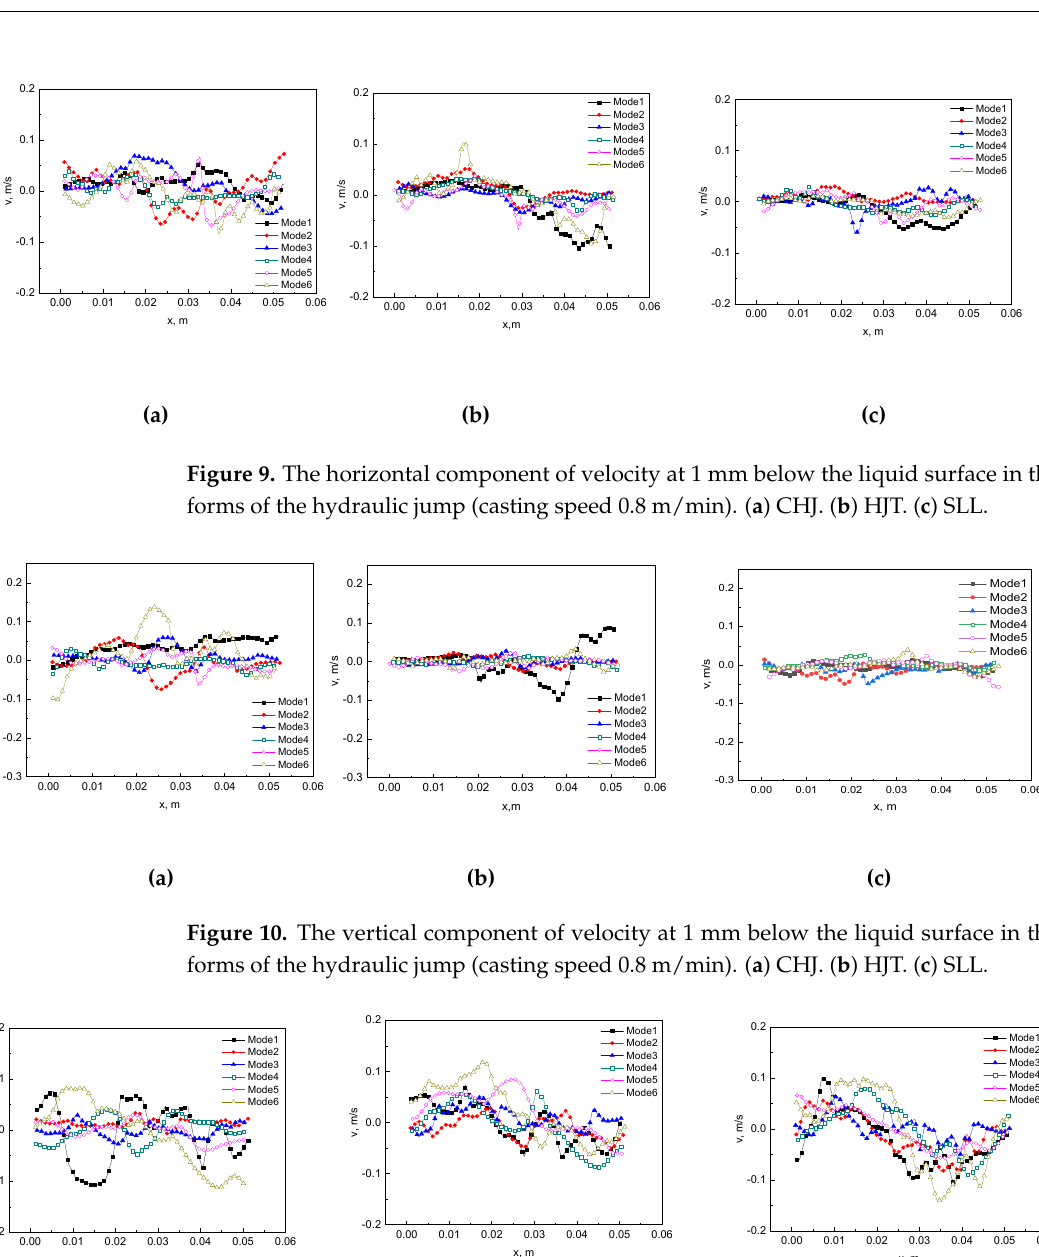
Figure 10. The vertical component of velocity at 1 mm below the liquid surface in three physical forms of the hydraulic jump (casting speed 0.8 m/min). ( a ) CHJ. ( b ) HJT. ( c ) SLL